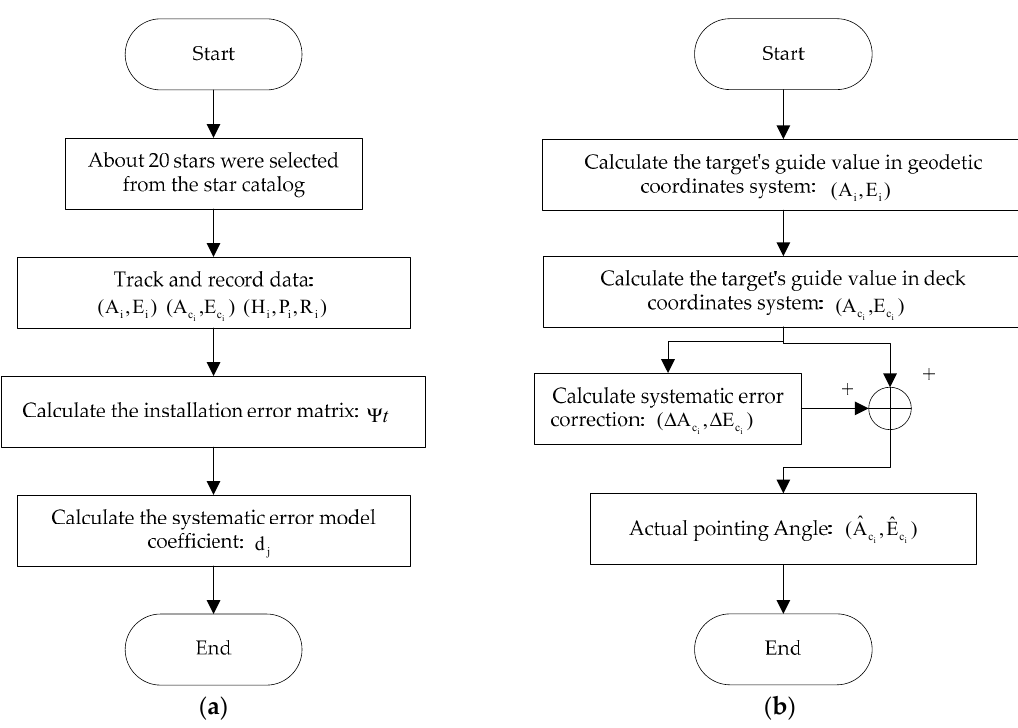
Figure 5. Installation and systematic error model calculation and application process. ( a ) Installation and system error model calculation flow chart. ( b ) Flow chart of actual use.